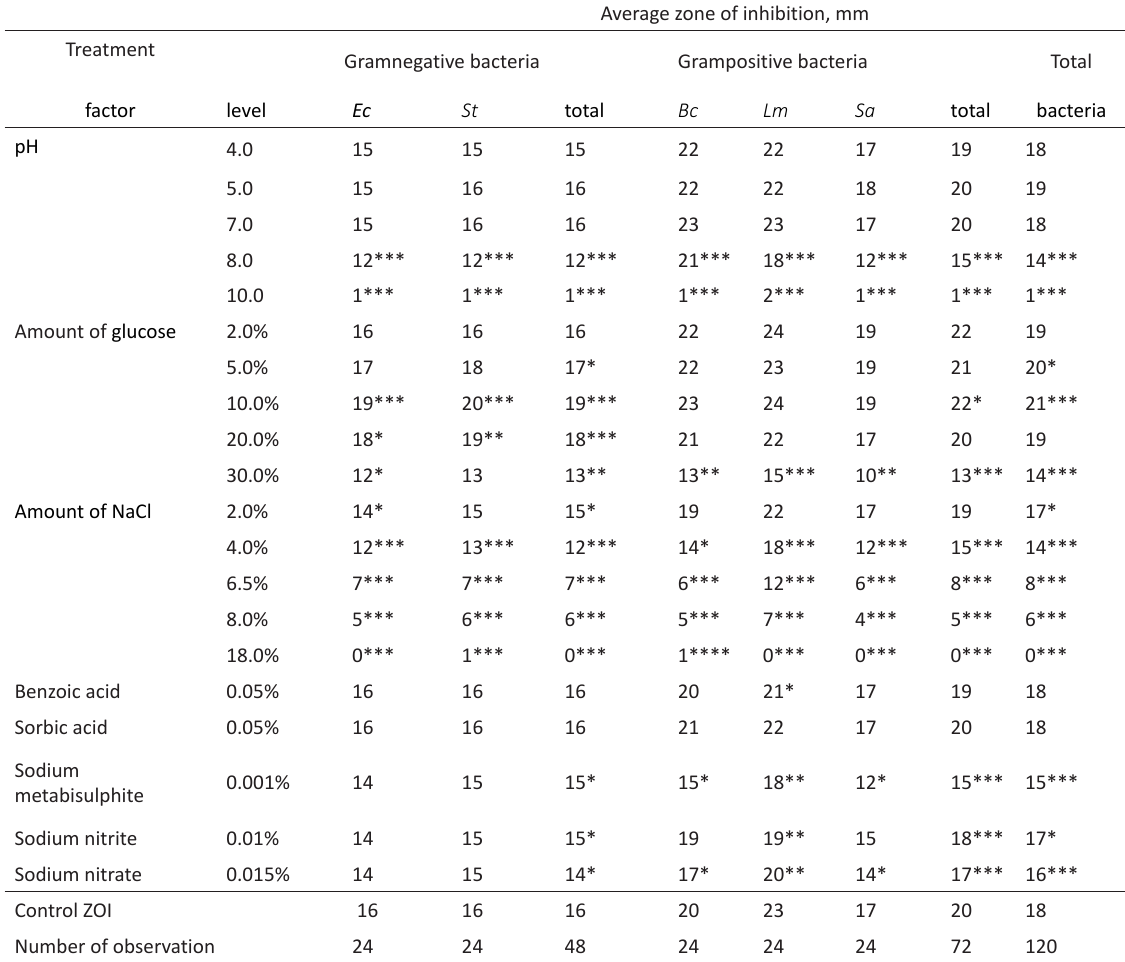
The inhibition of antibacterial activity caused by the initial pH was stronger and more variable against gramposi- tive bacterial species (Table 3). Table 3. Average zones of inhibition and statistical significance of the treatment effect on antibacterial activity of the analyzed LAB strains Average zone of inhibition, mm Treatment Gramnegative bacteria Grampositive bacteria